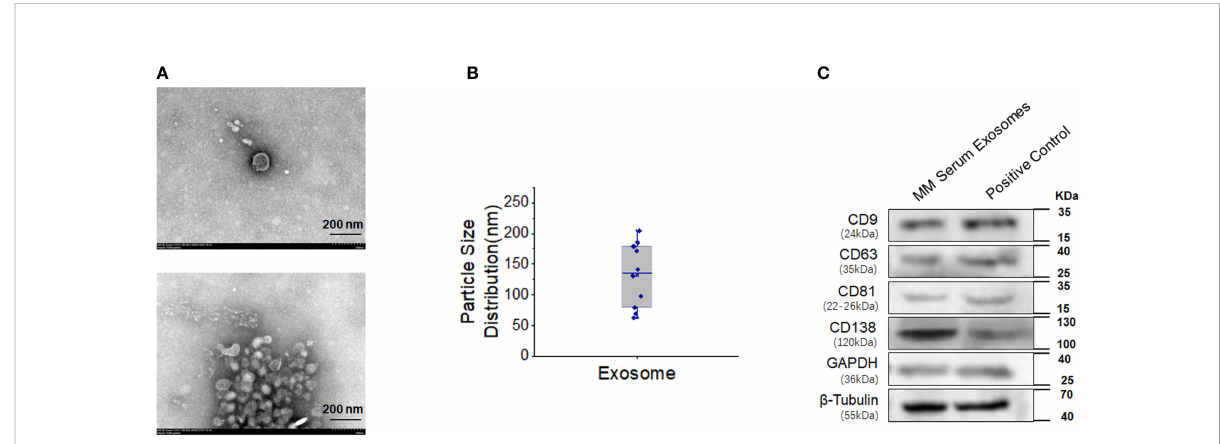
FIGURE 4 High expression of CD138 in exosomes derived from MM. (A) Negative transmission electron microscopy (TEM) staining was used to assess the exosomes extracted from the blood supernatants of MM patients (magni fi cation 40.0k×). (B) Diameter analysis of exosomes. (C) Western blotting was used to detect the surface marker expression of these exosomes, and the protein extracted from MM bone marrow mononuclear cells were used as the positive